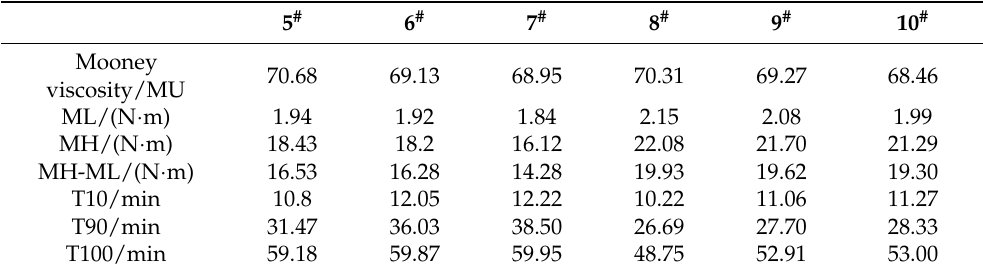
Table 5. Vulcanization characteristics of rubber composites after modification with spent FCC